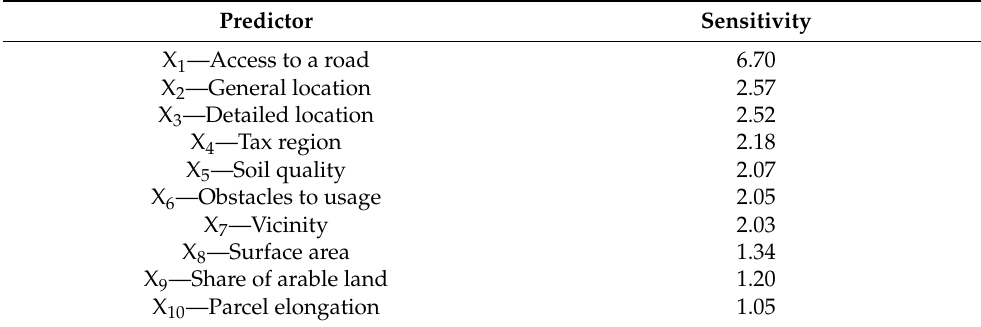
Table 3. Network sensitivity